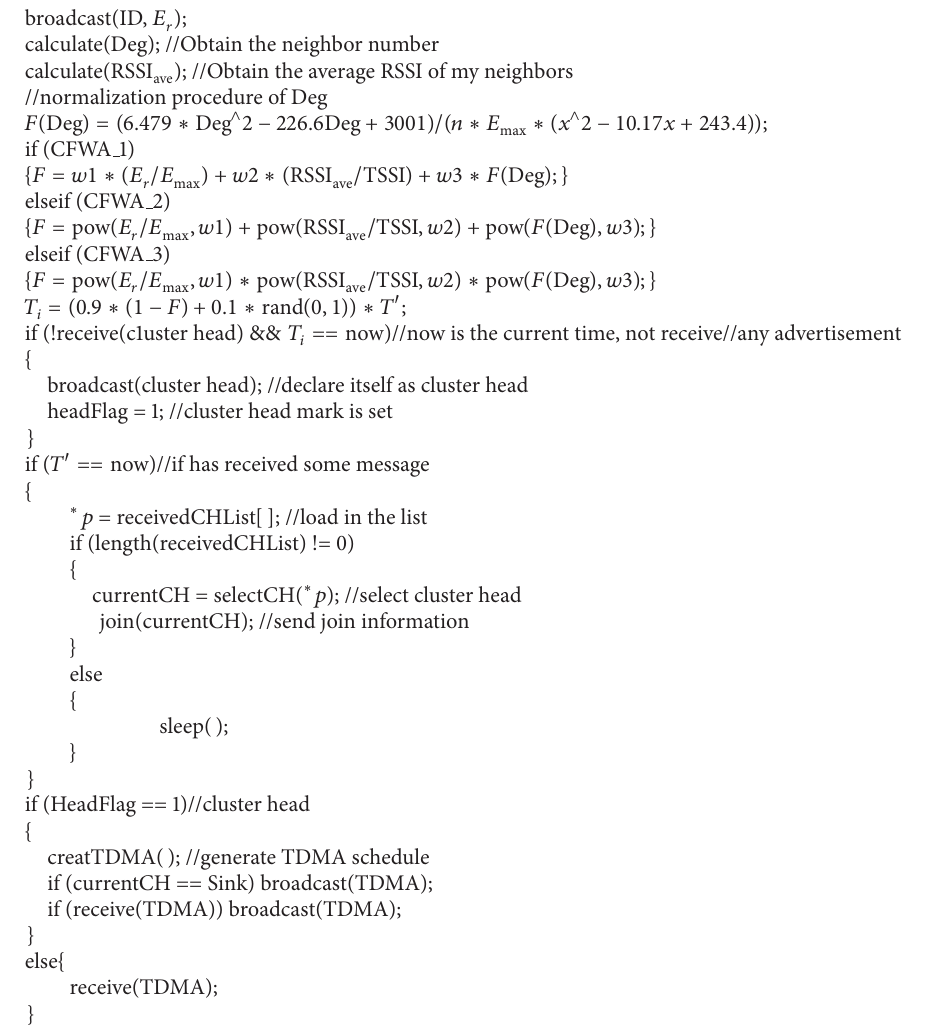
Algorithm 2: The pseudocode implementation of the setup phase.